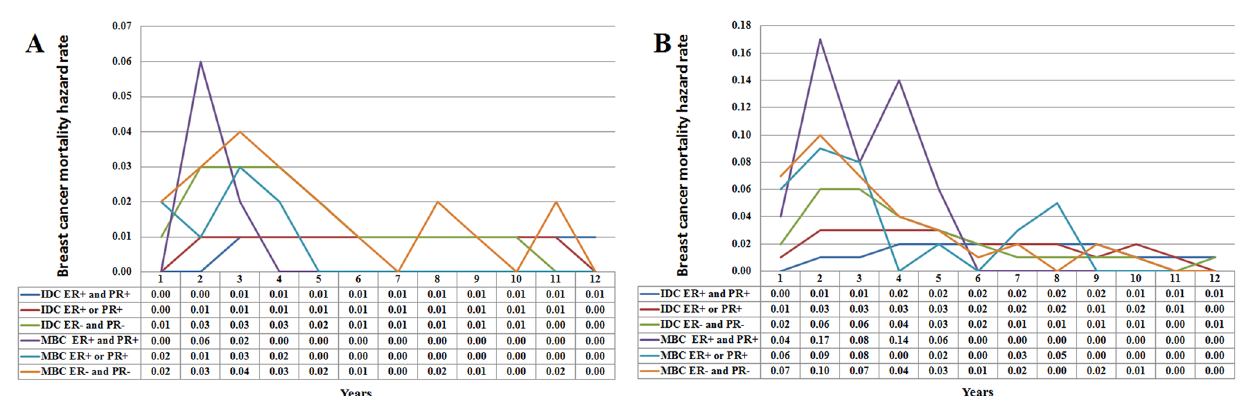
Figure 5. Annual hazard rates for breast cancer mortality in invasive ductal carcinoma and metaplastic breast carcinoma by hormone receptor status in breast conserving surgery cohort ( A ) and mastectomy cohort ( B